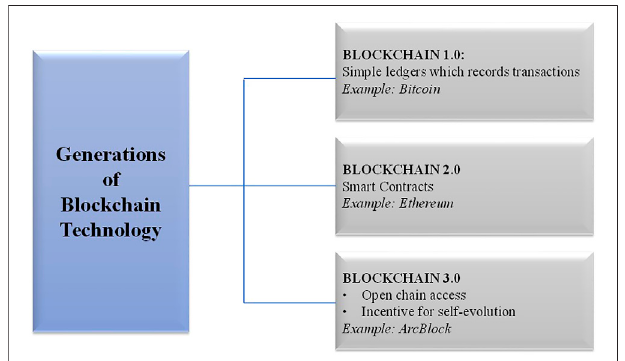
FIGURE 1 | Generations of blockchain technology. Source (Cummings,